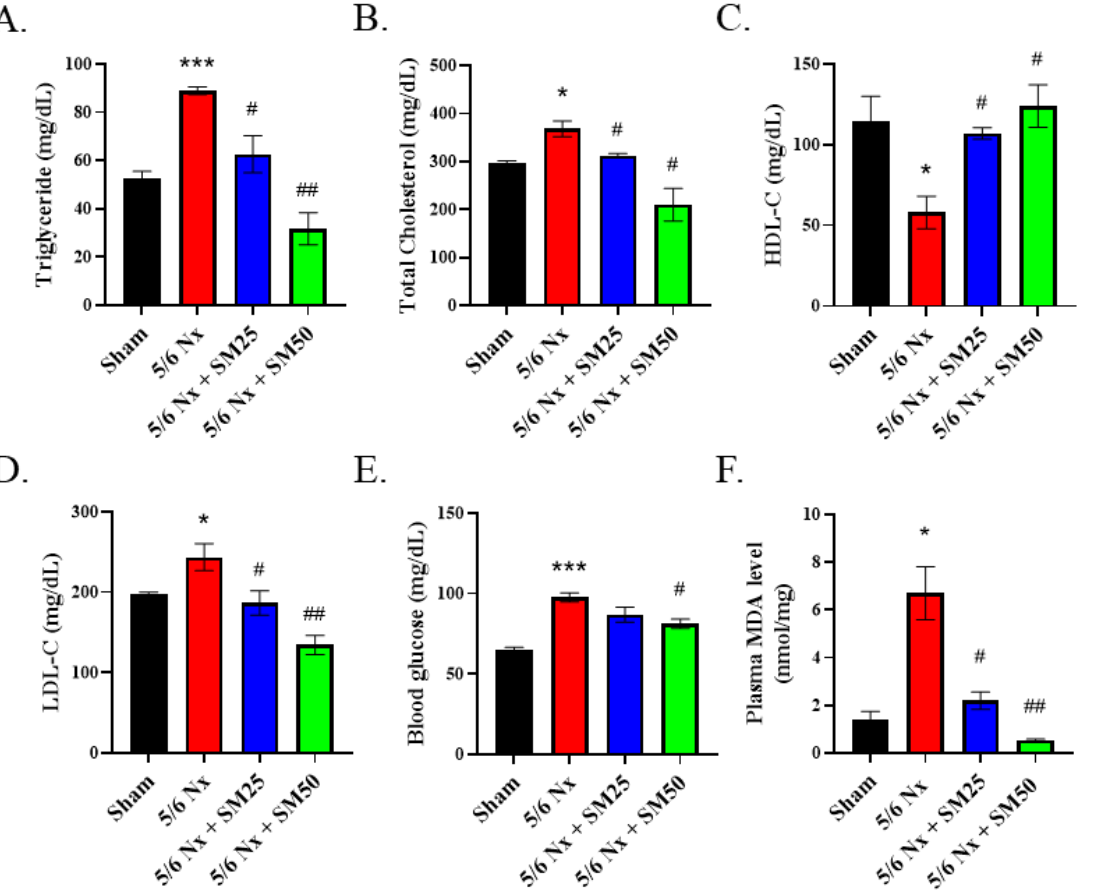
Figure 3. Biochemical analyses of the plasma of female ApoE –/– mice subjected to different treatments. Levels of ( A ) triglycerides, ( B ) total cholesterol, ( C ) HDL-cholesterol, ( D ) LDL-cholesterol, ( E ) blood glucose, and ( F ) plasma MDA. Data are expressed as the mean ± SEM ( n = 6). * p < 0.05, *** p < 0.001 vs. sham group. # p < 0.05, ## p < 0.01 vs. 5/6 Nx group.